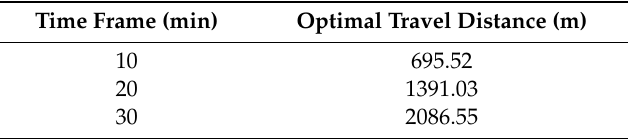
Table 5. Optimal travel distances for the three time frames.